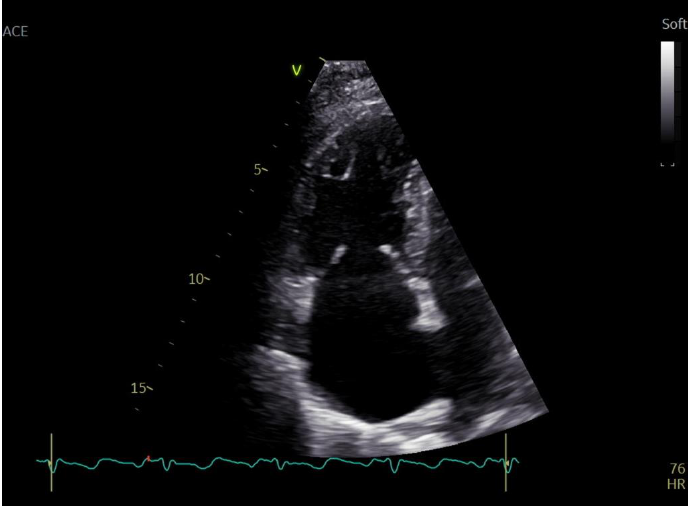
Figure 1. Retracted and thickened tricuspid valve with reduced mobility.